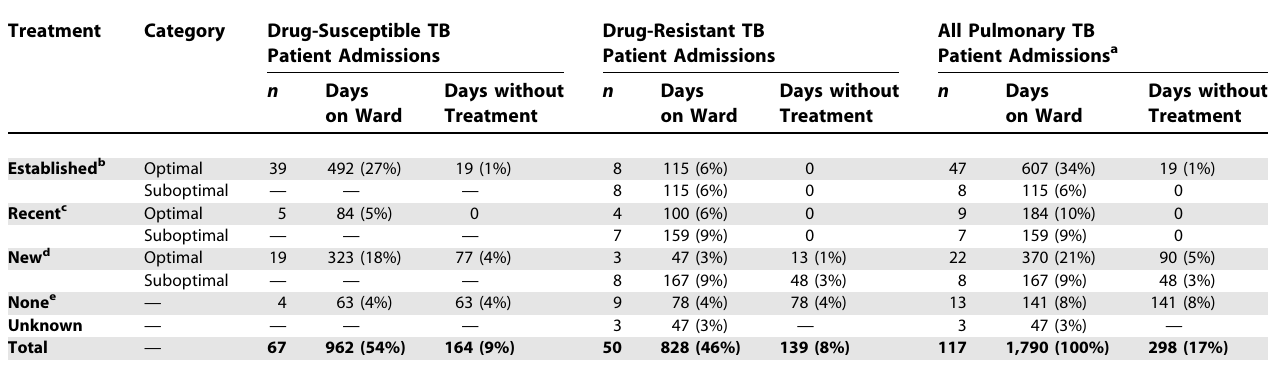
Table 1. Antituberculosis Chemotherapy Treatment Status of Confirmed and Presumed Drug-Susceptible and Drug-Resistant Pulmonary TB Admissions to the